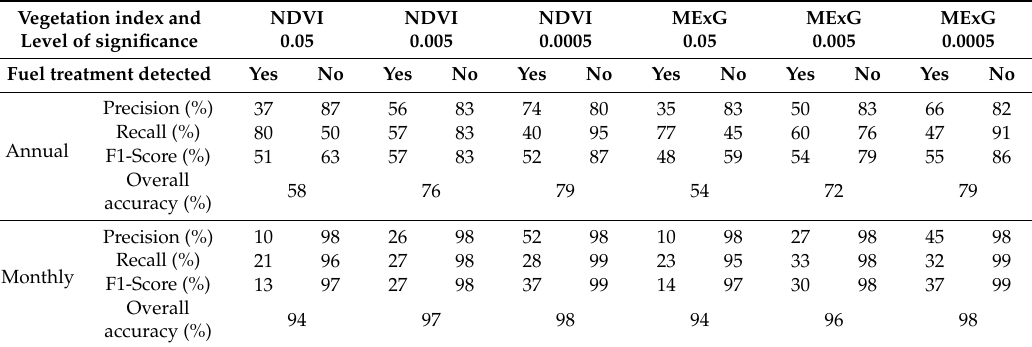
Table 4. Global accuracy results for Method 2, at annual and monthly steps.